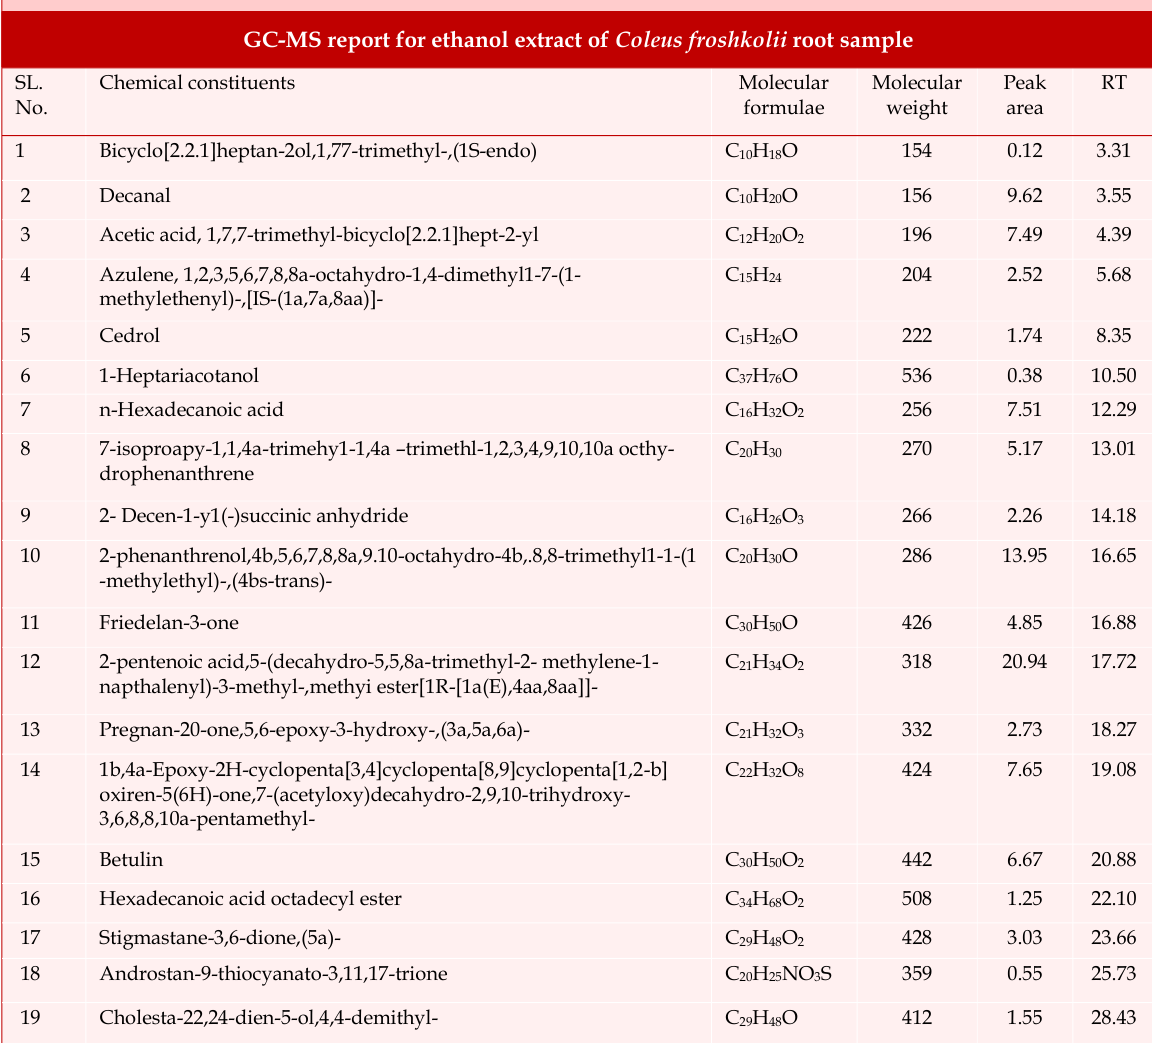
GC-MS report for ethanol extract of Coleus froshkolii root sample SL.